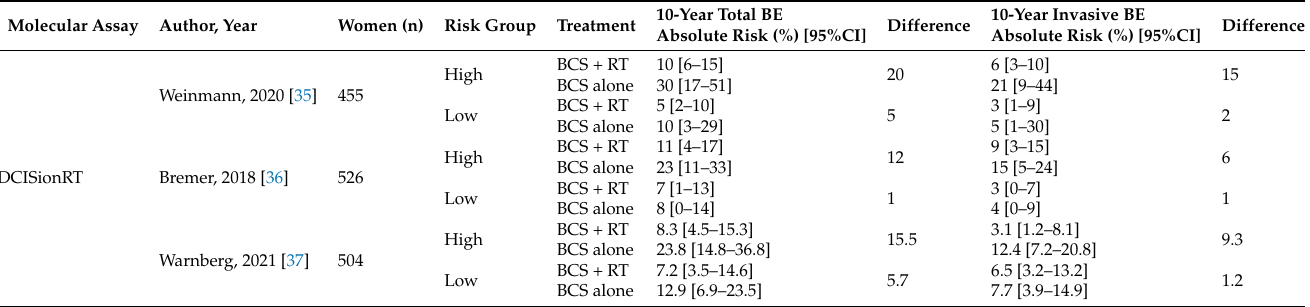
Table 2. DCISonRT 10-year absolute risk of local recurrence stratified by treatment, risk group and recurrence